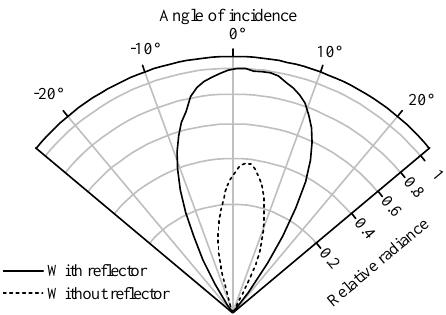
Figure 4. Simulation result showing the angular distribution of the light passing through the bandpass filters for emitters with and without